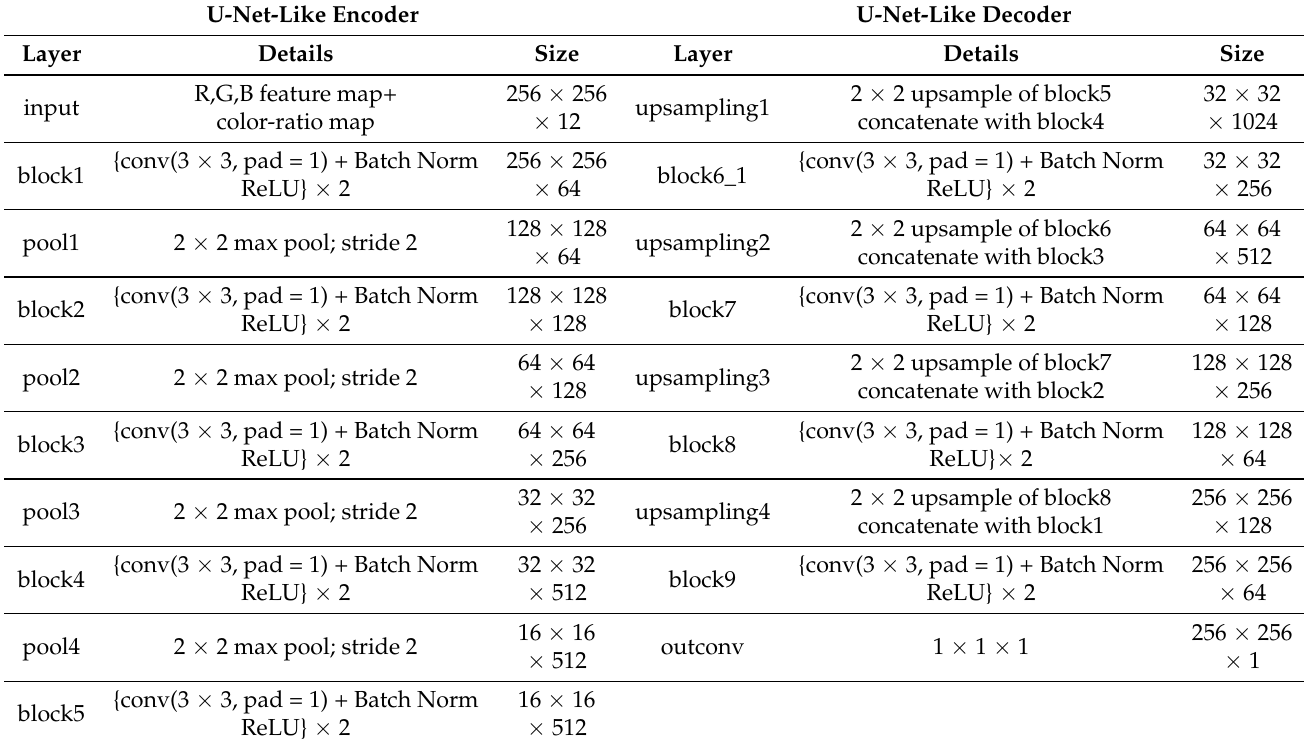
Table 1. The “U-Net-like”-based segmentation